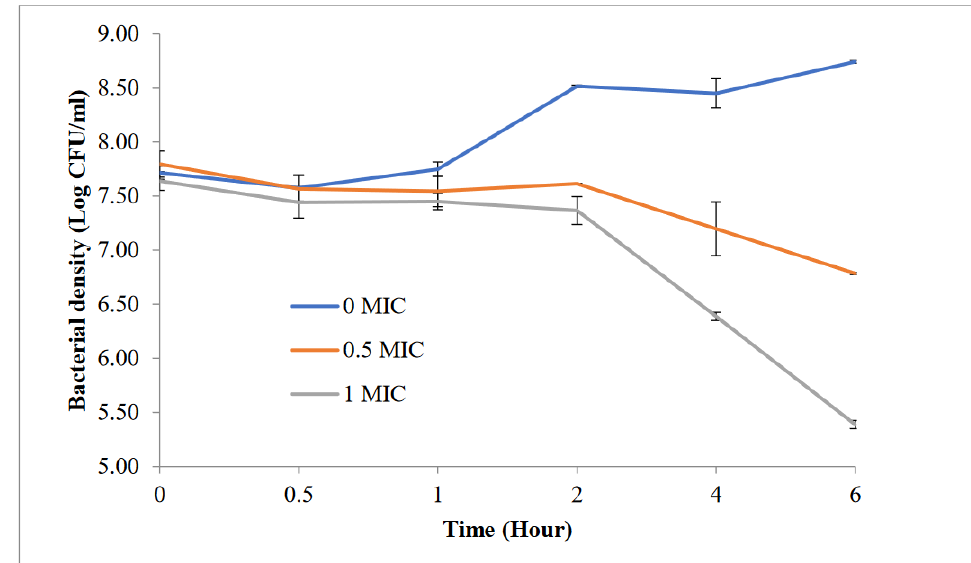
Figure 1. Time-kill of Pseudomonas aeruginosa ATCC 27,853 in the presence of cinnamon extract. CE concentrations: 0% ( v / v ); 0.5% ( v / v ); 1.0% ( v / v ). Bars show the SD of two independent experiments and a total of 4 replicates ( n = 4).